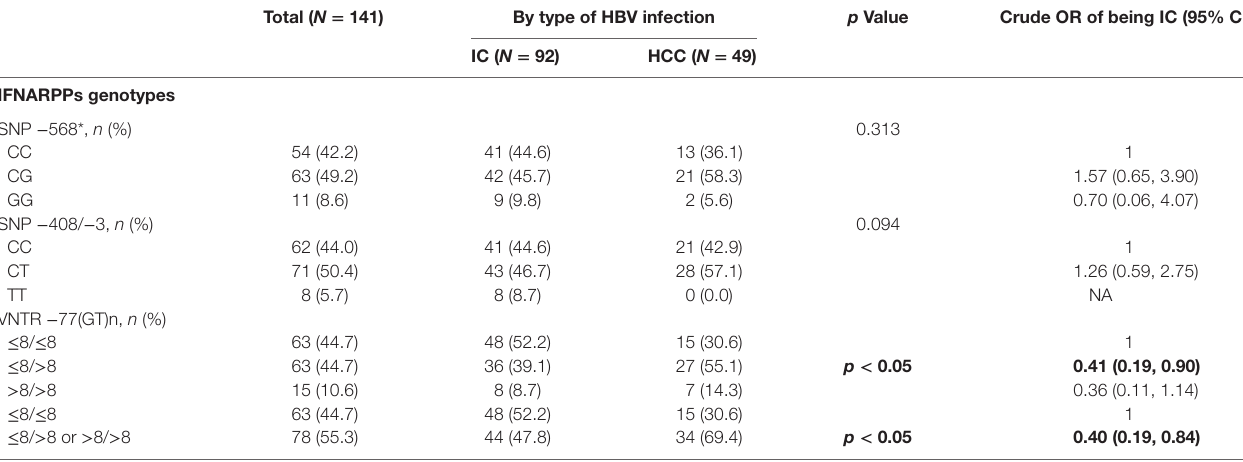
TaBle 3 | Genotypes of patient samples in relation to clinical